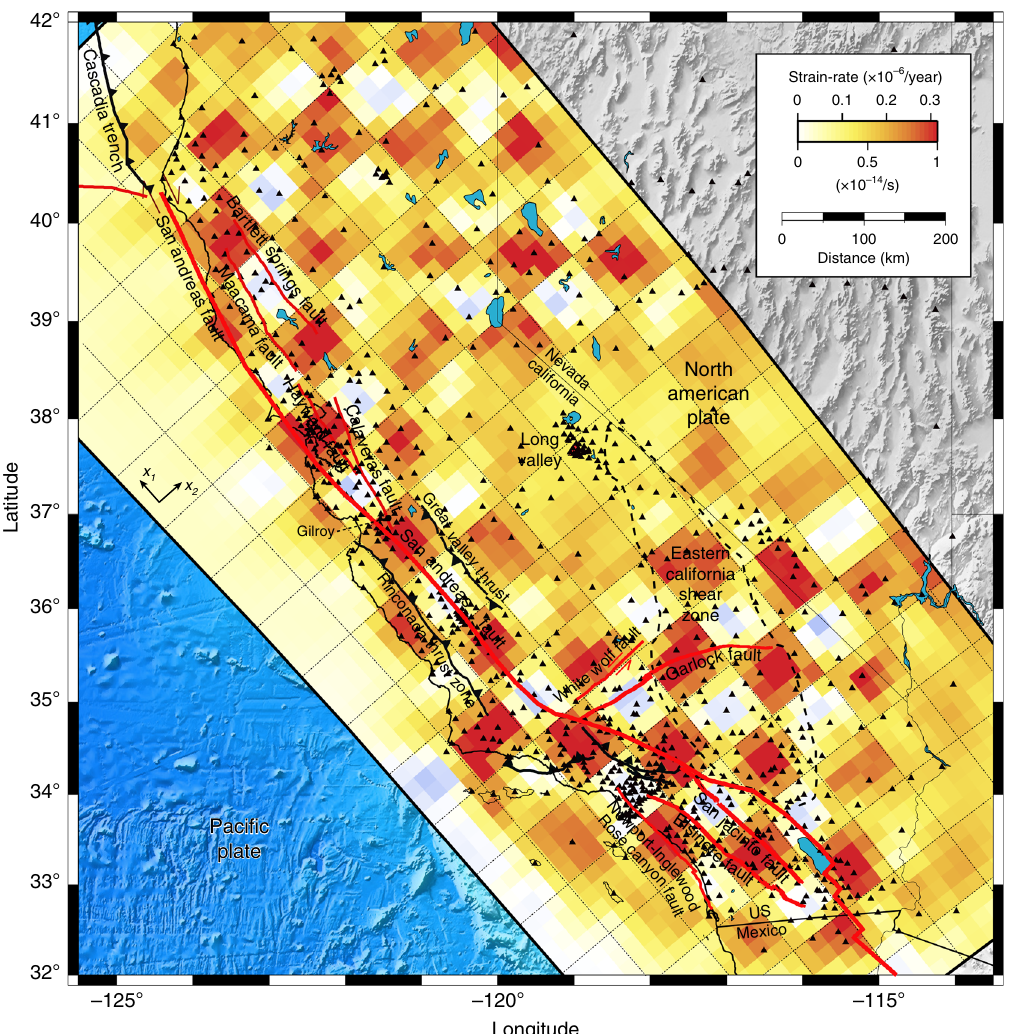
Fig. 2 Checkerboard test for inversion of plastic strain-rate. The checkerboard pattern of strain-rate consisting of clusters of four by four neighboring volume elements with non-zero shear strain-rate is indicated by the dashed lines. The recovered pattern after inversion of the synthetic data (black triangles) is in the colored background. Loss of resolution occurs offshore and around the Long Valley Caldera due partly to insuf fi cient station